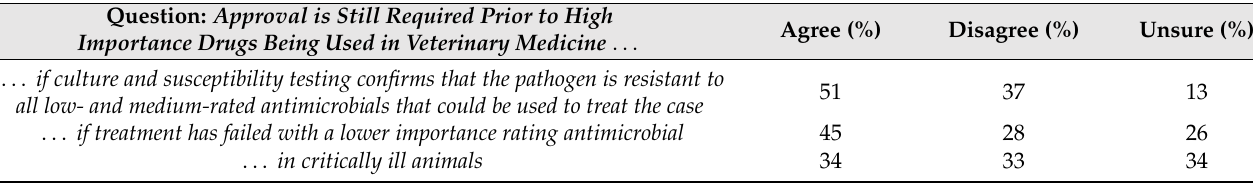
Figure 3. Responses of clinical and non-clinical veterinarians to the question “If there were to be restrictions placed on veterinary prescribing of antimicrobials with high importance rating, which of the following do you think is appropriate? Table 1. Scenarios requiring approval—responses of all